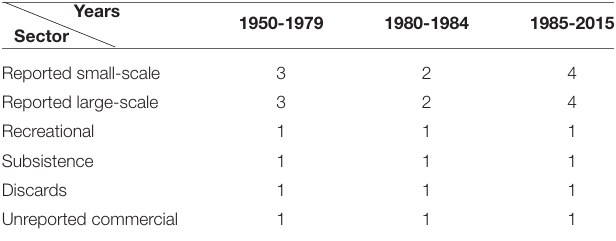
TABLE 4 | “Score” assigned for each sector and period of